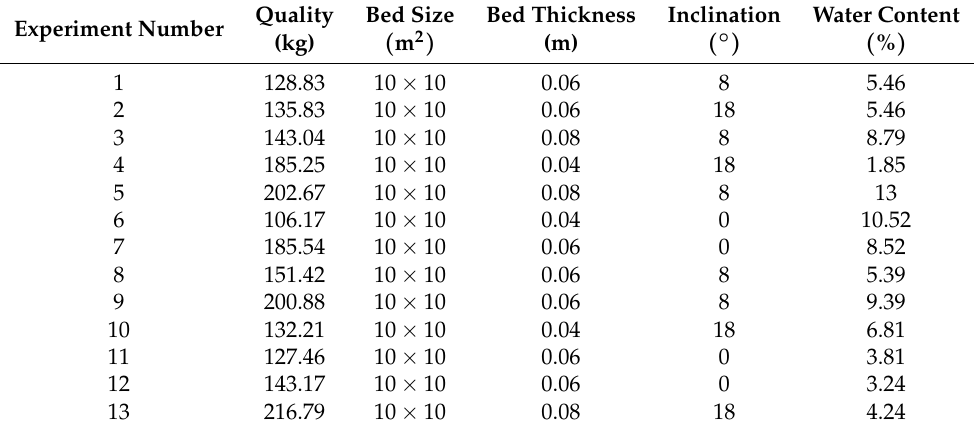
Table 2. Controlled parameters for each fire spreading